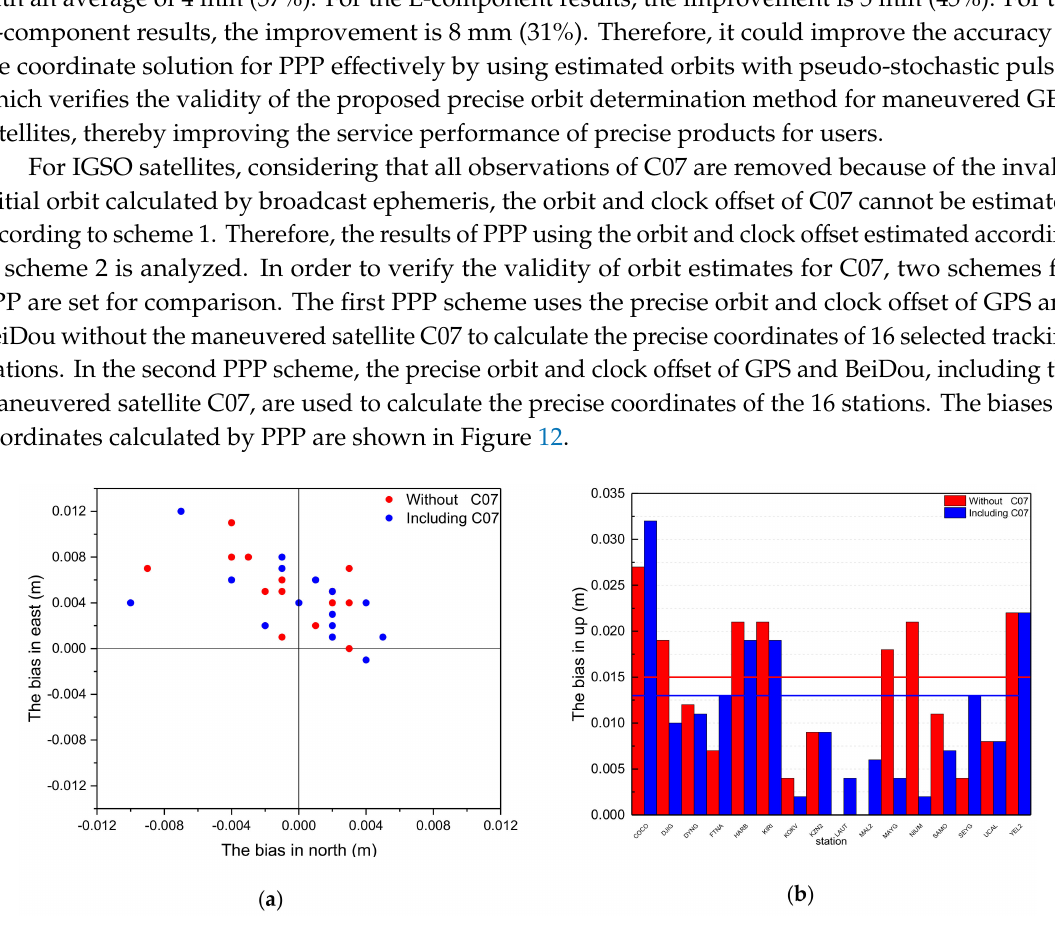
Figure 12. Bias of coordinates calculated by PPP using estimated orbits of GPS and BeiDou with and without C07: ( a ) in the north and east (NE) directions; ( b ) in the up (U)